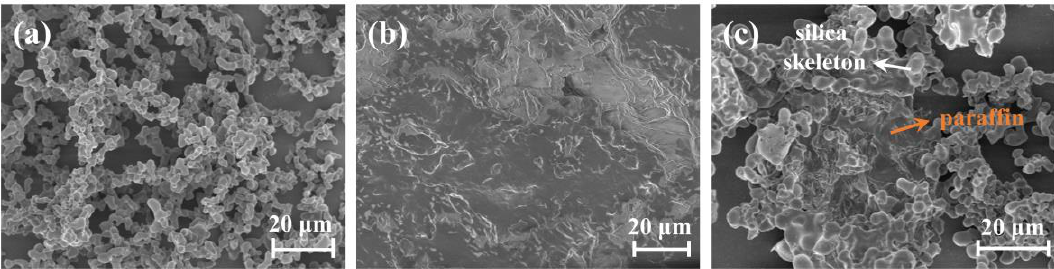
Figure 2. The microstructures of ( a ) the MSA, ( b ) paraffin and ( c ) paraffin/MSA composites.